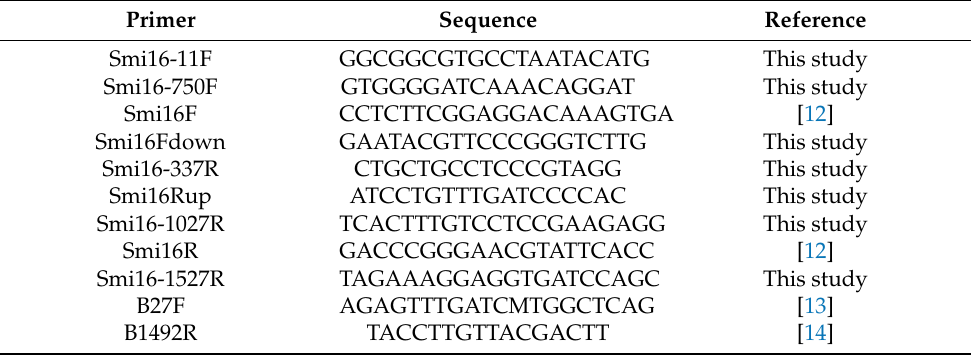
Table 1. Primers used for the PCR sequencing of the 16S ribosomal